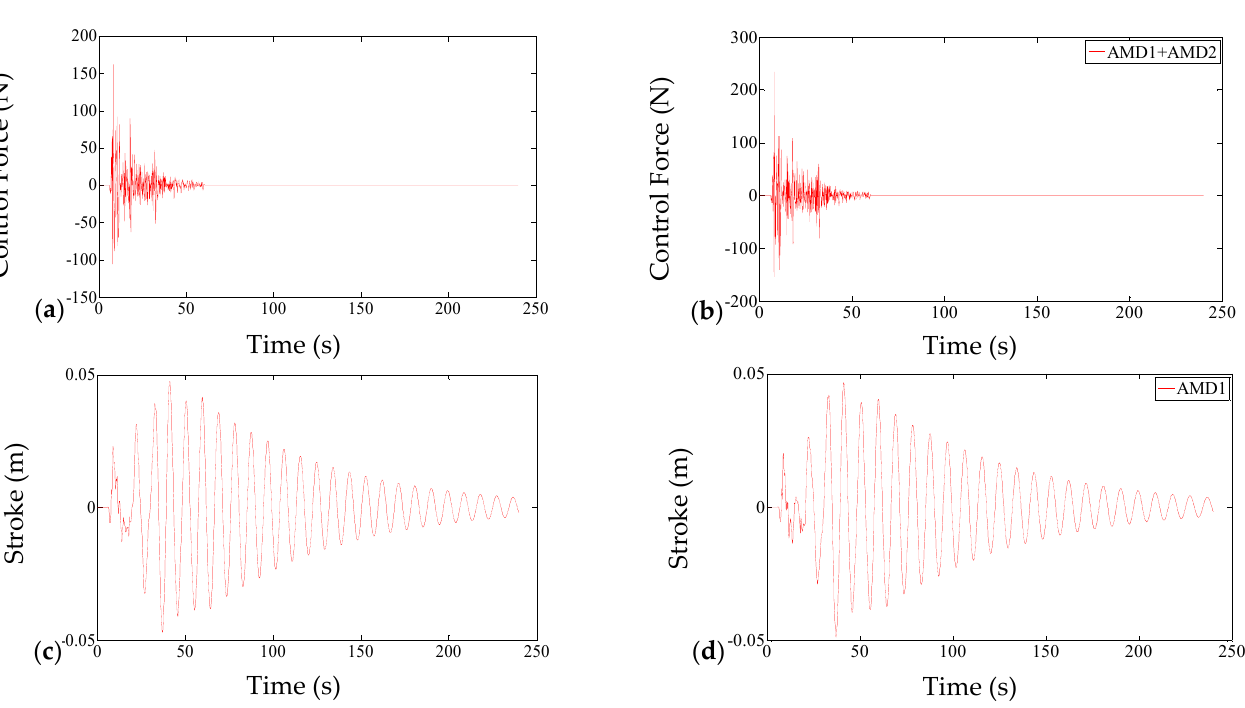
Figure 4. The deviations to the control parameters of System2 without time delays, ( a ) the forces and ( b ) the strokes.